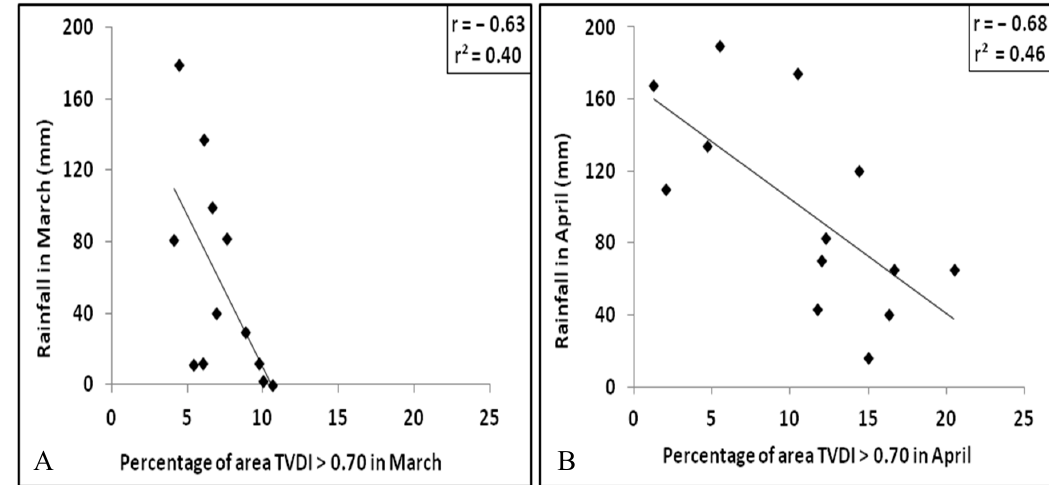
Figure 6. Relationship between highTVDI and rainfall at selected meteorological stations. In graph 6A, we used 12 years of data, and in graph 6B, we used 13 years of data; ( A ) Percentage of area TVDI > 0.70 in March; ( B ) Percentage of area TVDI > 0.70 in April